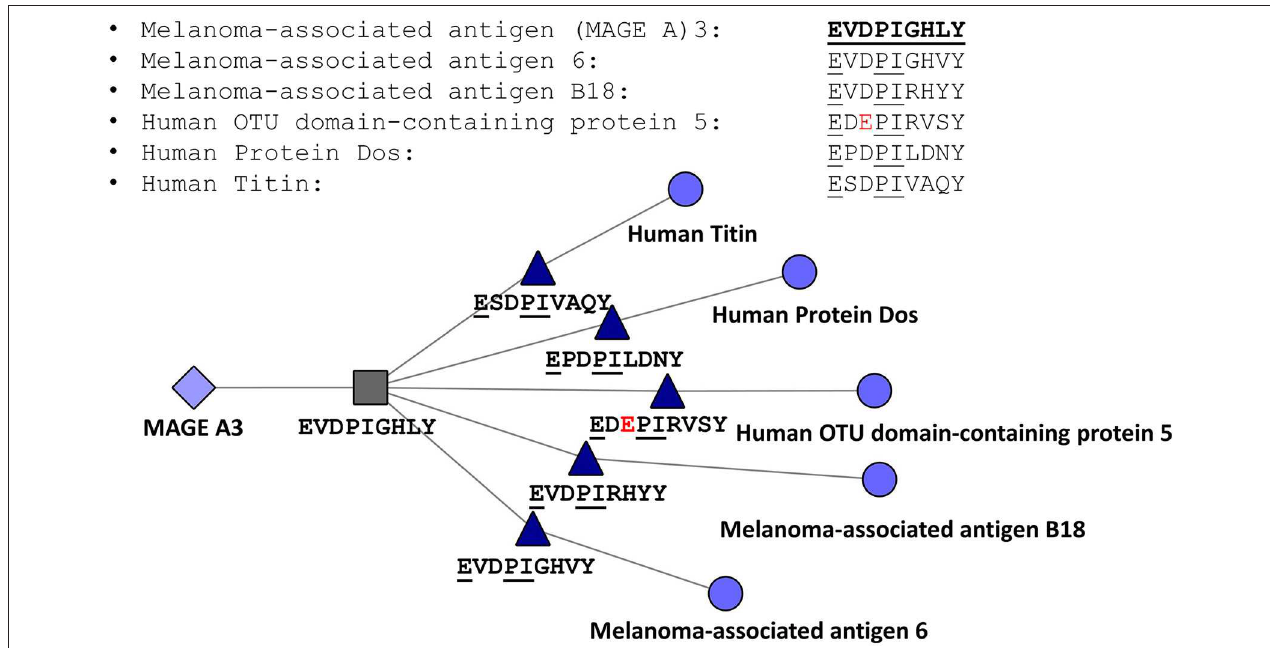
FIGURE 7 | JanusMatrix Analysis of MageA3-HLA*0101-restricted T cell epitope. Peptides containing identical T cell facing residues include variants of MageA3 (Melanoma Associated Antigen) and three additional human proteins, including human titin, one of the components of cardiac smooth muscle. The figure shows that the HLA-A*0101-restricted T cell epitope EVDPIGHVY is conserved with an epitope that has identical HLA binding restriction but slightly different agretope (XSPDXXVAQY) and identical TCR facing residues